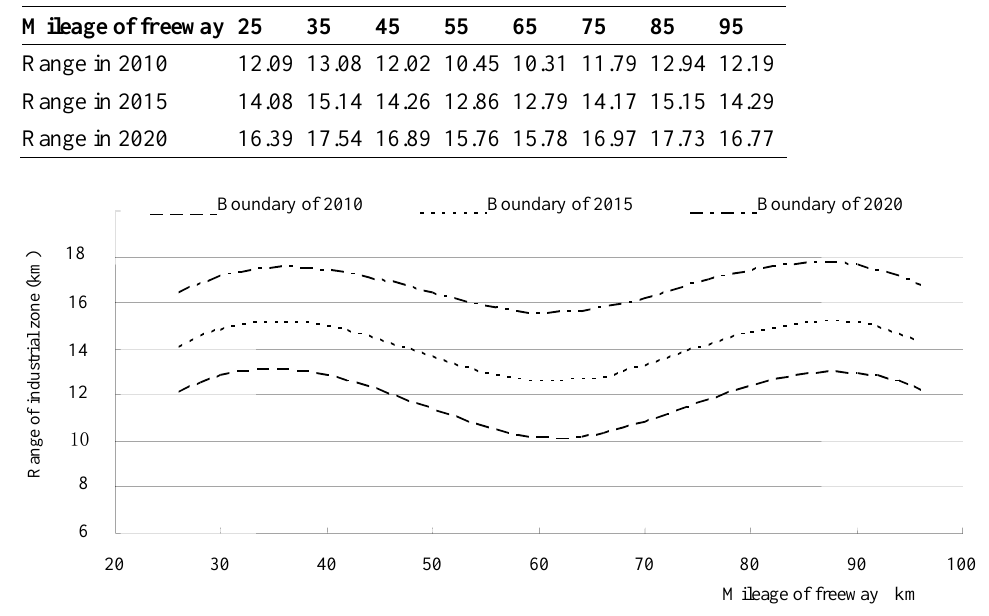
Figure 3. The boundary function of the industrial zone along Ha-Shuang freeway